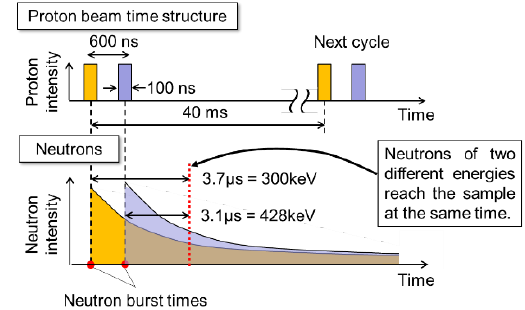
Fig. 1. Time structure of double-pulse mode operation of J- PARC/MLF and neutron